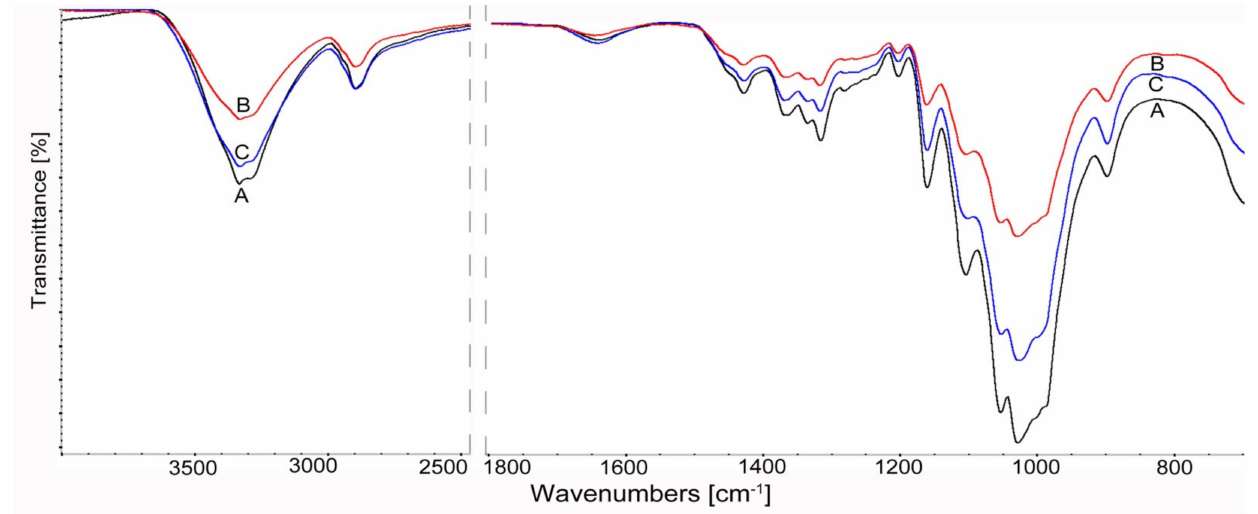
Figure 4. FTIR spectra of cellulose Cel_A after enzymatic reaction in the range 4000–500 cm − 1 : A Cel_A, B Cel_A-Tr, C